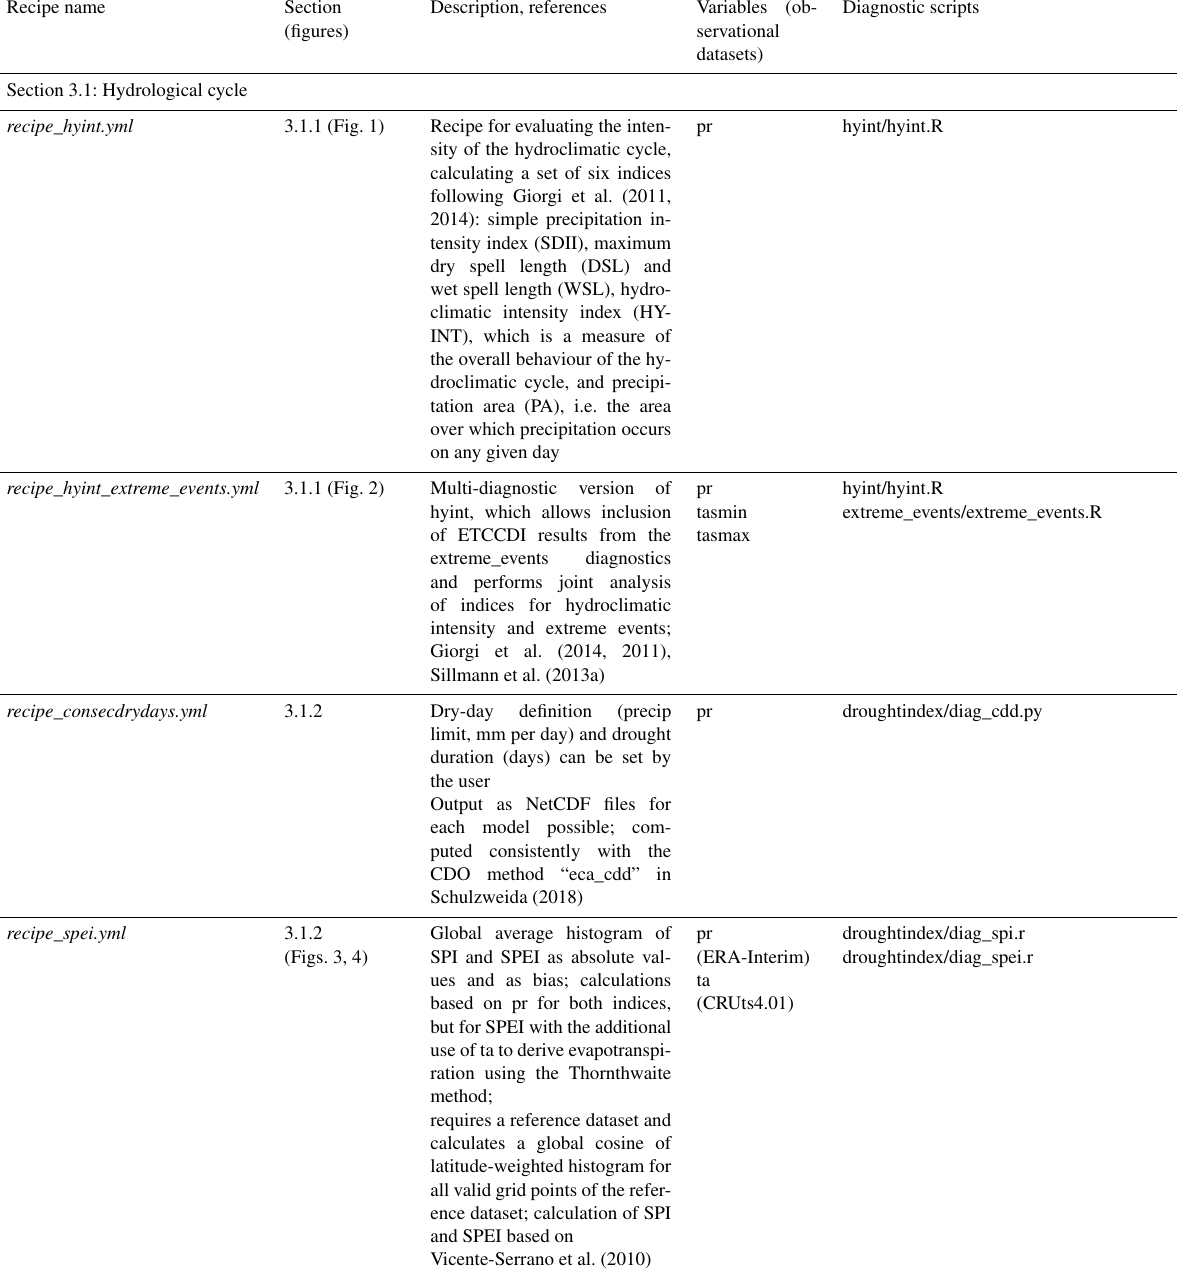
Table 1. Overview of recipes implemented in ESMValTool v2.0 along with the section in which they are described, a brief description, the variables used, and the diagnostic scripts included. For further details, we refer to the GitHub repository and documentation at https: //docs.esmvaltool.org/ (last access: 1 June